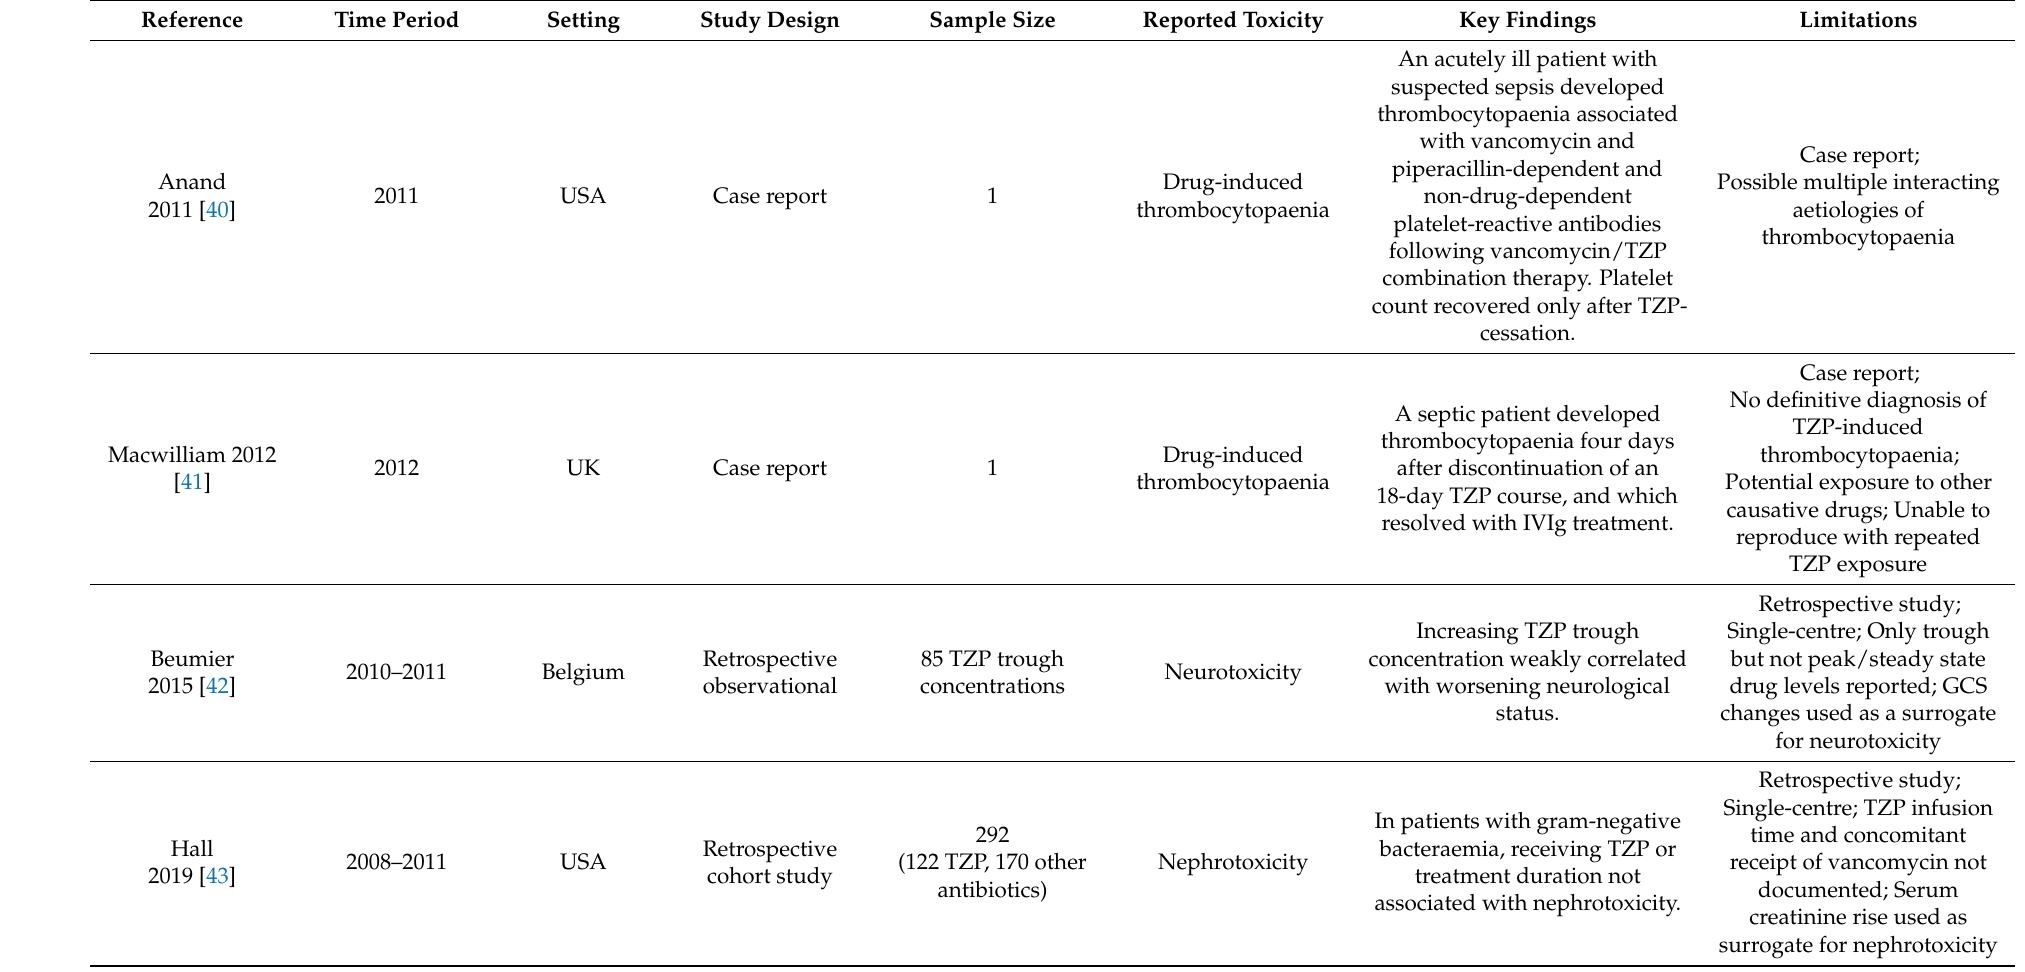
Table 2. Studies reporting TZP toxicity in septic